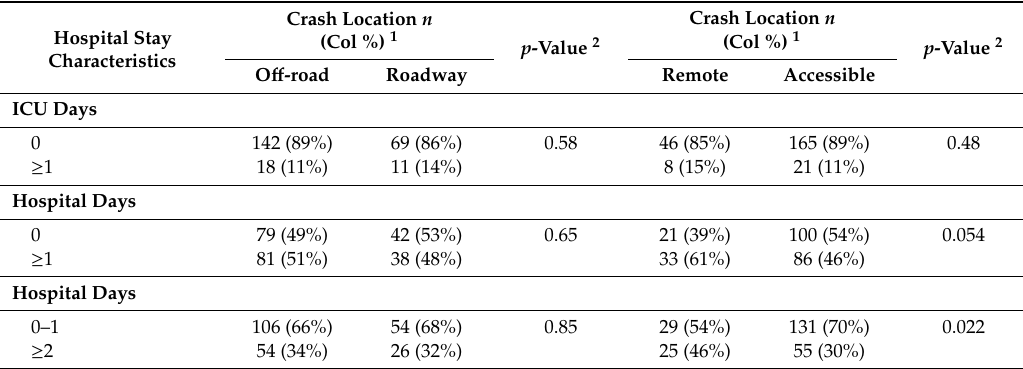
Table 4. Hospital length of stay for all-terrain vehicle crash patients transported via emergency medical services ground ambulance by crash location (2004–2014), available for State Trauma Registry data only: roadway (N = 80), o ff -road (N = 160), remote (N = 54), accessible (N = 186). Hospital Stay